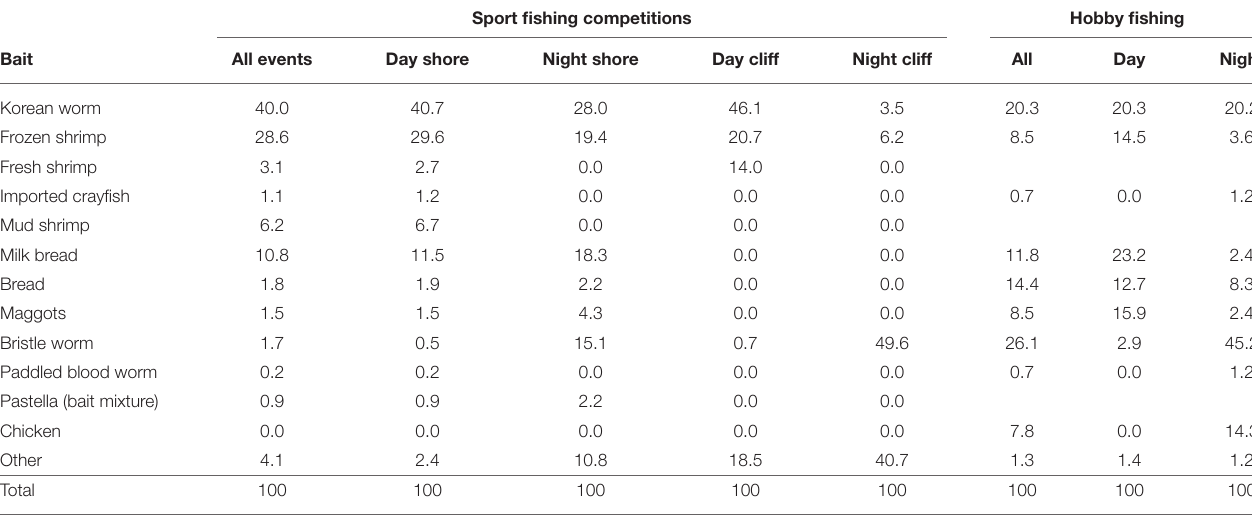
TABLE 3 | Bait used during fishing competitions and hobby fishing.